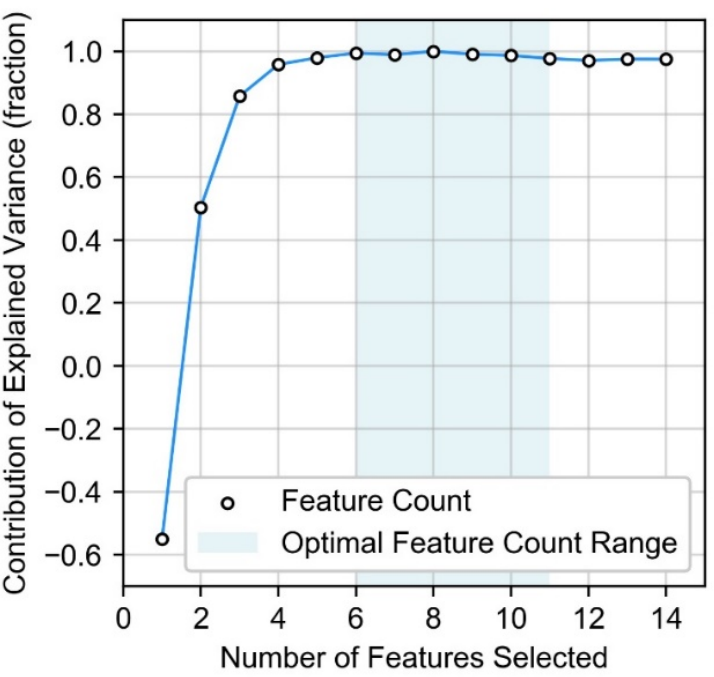
Figure A1. Effect of feature inclusion relative to the highest feature count score.